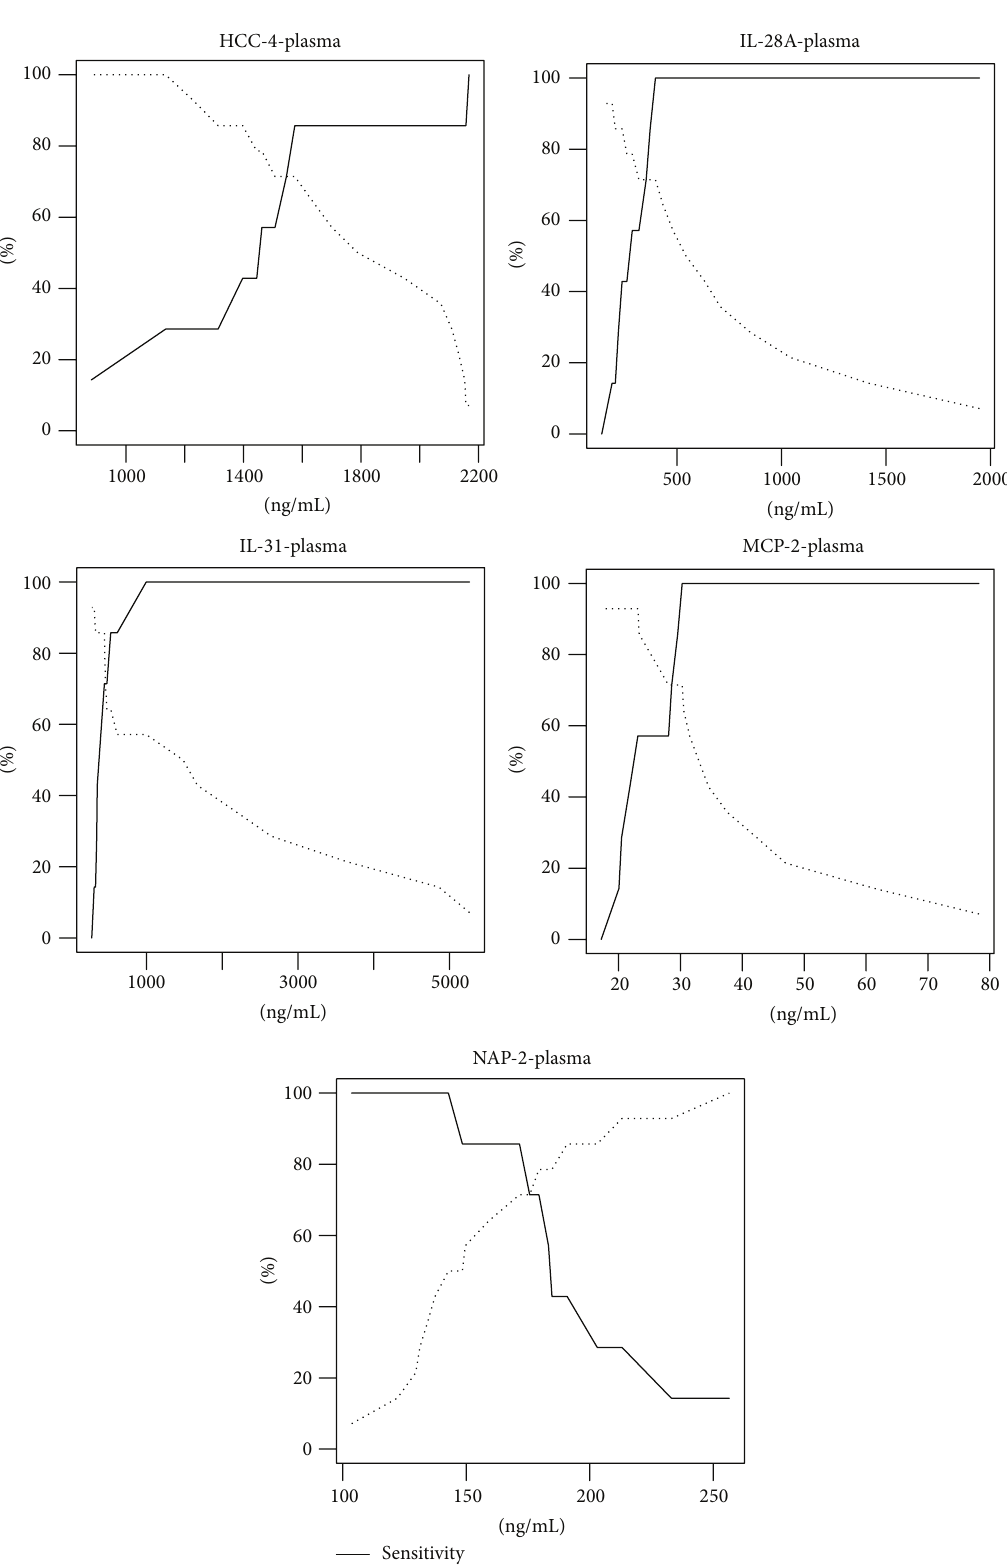
Figure 2: Sensitivity and specificity of markers in plasma: HCC-4, IL-28A, IL-31, MCP-2, and NAP-2